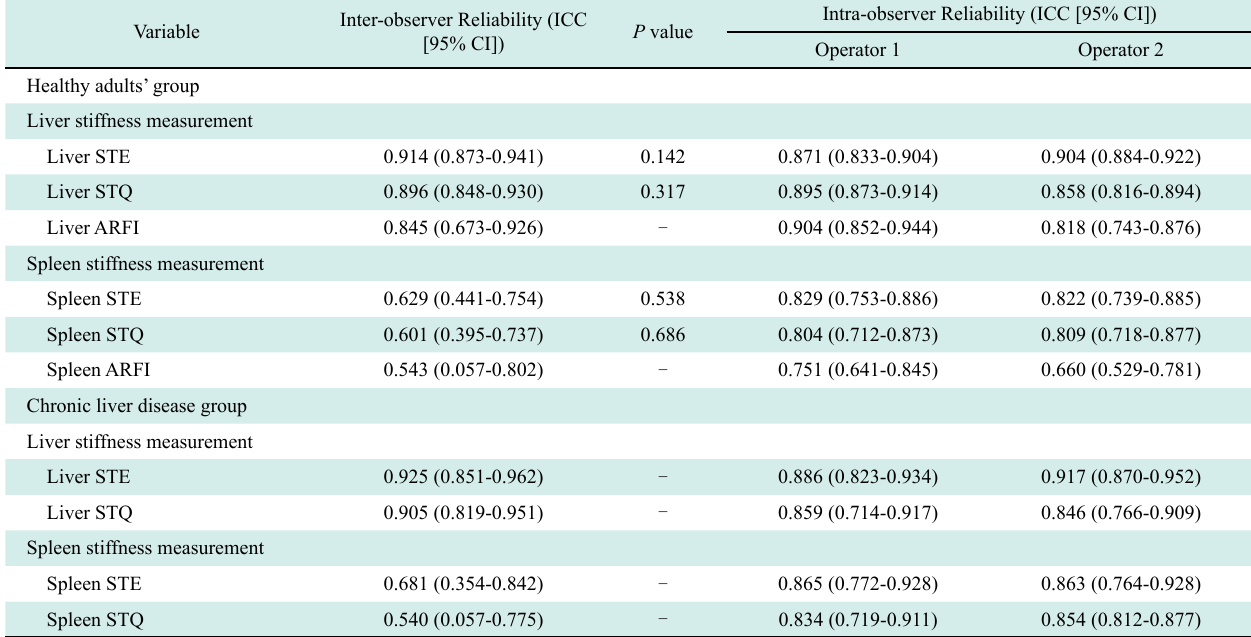
Table 2 Inter-observer reliability and intra-observer reliability for liver and spleen STE and STQ